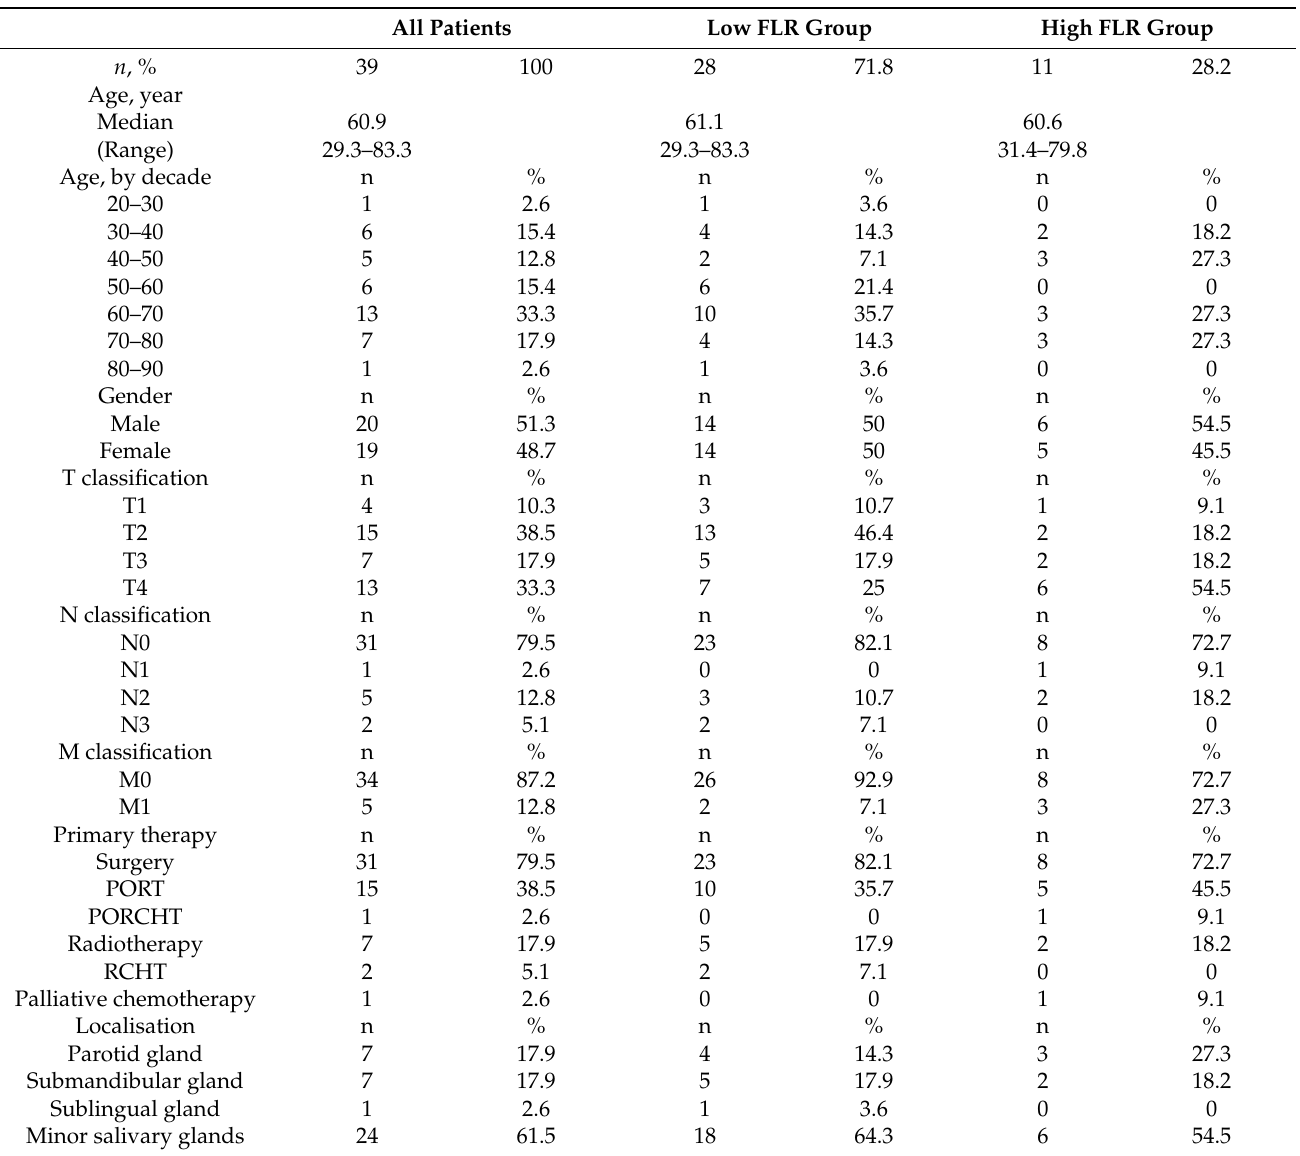
Table 1. Patient demographics, tumor characteristics with treatment approaches. n; number of patients, FLR; fibrinogen-to- lymphocyte ratio, PORT; postoperative radiotherapy or photon therapy, PORCHT; postoperative chemoradiotherapy or postoperative chemotherapy and photon therapy, RCHT; primary chemoradiotherapy or primary photon therapy with concomitant